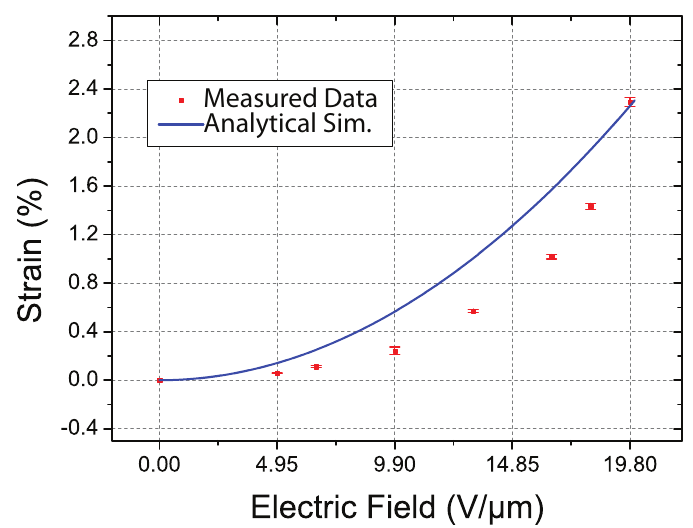
Figure 10. Simulated and measured axial strain values in proposed cylindrical DEA under external electrical stimuli ranging from 0 V to 9.9 kV, which corresponds to an electric field ranging from 0 to 19.8 V/ µ m (curve indicates simulation results obtained using the theoretical model described in Section 2.2; red points indicate average measured strain values and error bars indicate one standard